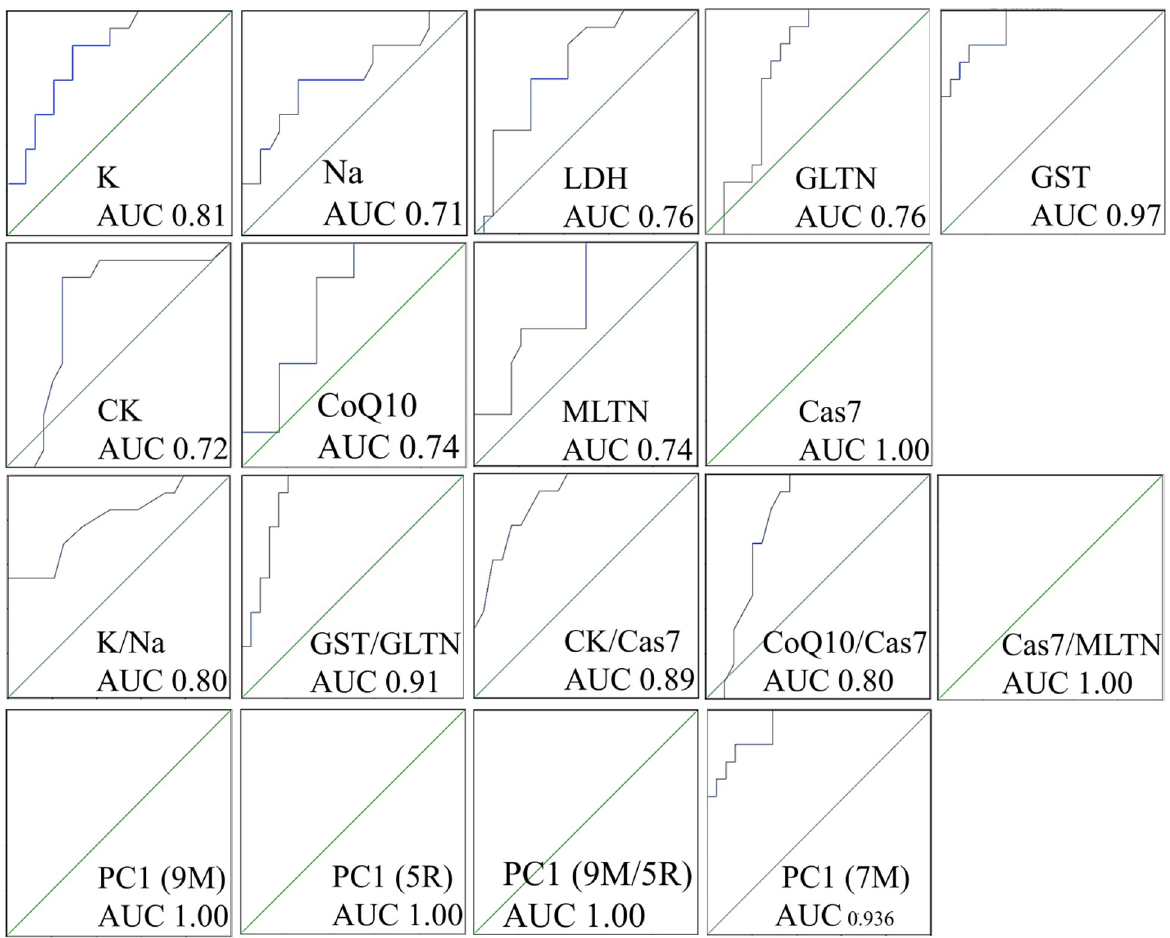
Fig 5. Receiver operating characteristic analysis to evaluate the predictive power of individual and multivariate combined biomarkers using the area under a receiver operating characteristic curve (AUC) method. 9M: 9-biomarkers (K, Na, LDH, GLTN, GST, CK, CoQ10, Cas7, and MLTN); 5R: 5 ratios (K:Na, GST:GLTN, CK:Cas7, CoQ10:Cas7, and Cas7:MLTN); 9M/5R: 9 biomarkers and 5 ratios; and 7M: 7 biomarkers (K, Na, LDH, GSH, CK, CoQ10, and MLTN). PC1: first principal component in a principal component analysis used as a multivariate biomarker